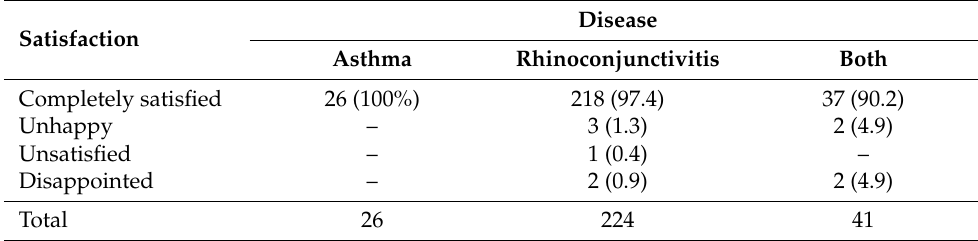
Table 6. Patient perceived health status and satisfaction at the end of